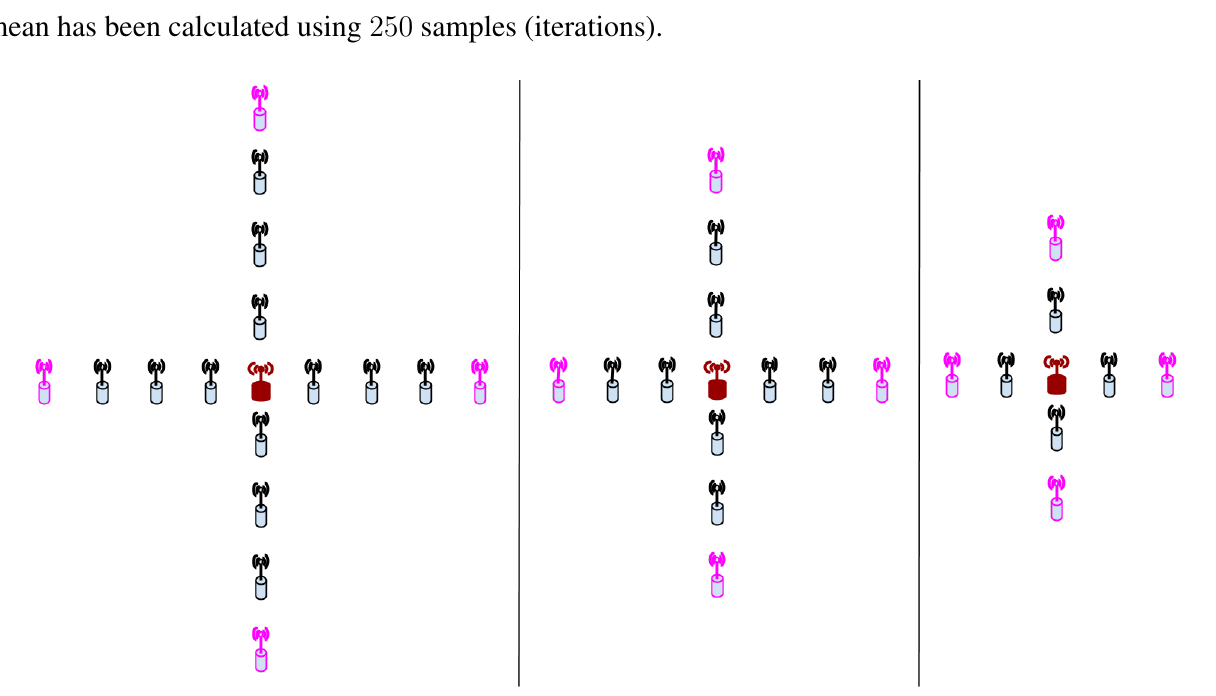
Figure 15. Multi-hop star topologies used for simulation.